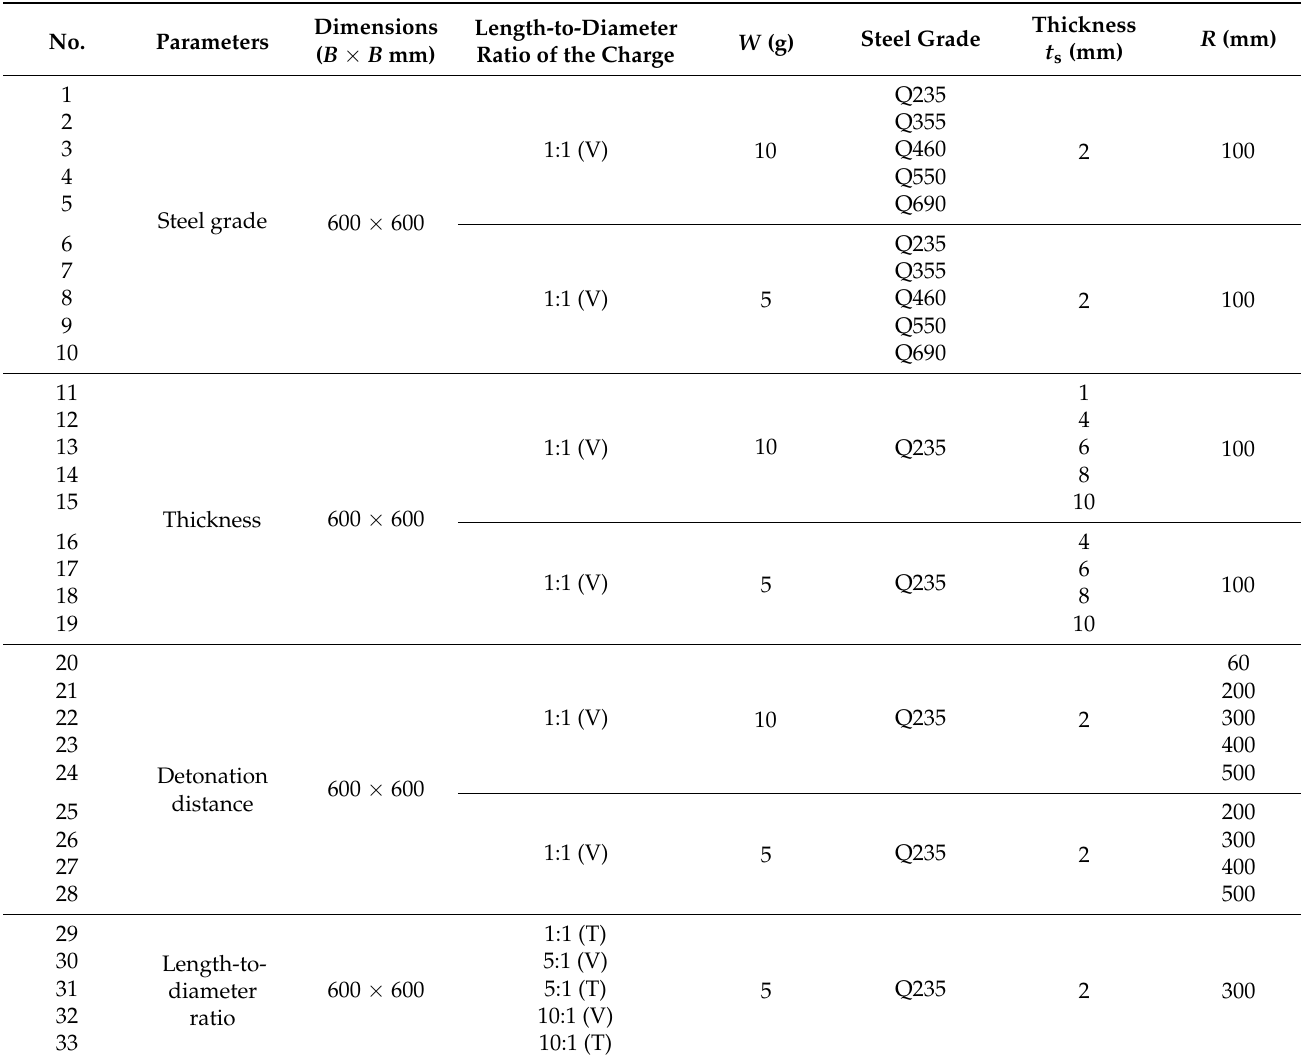
Table 2. Summary of test